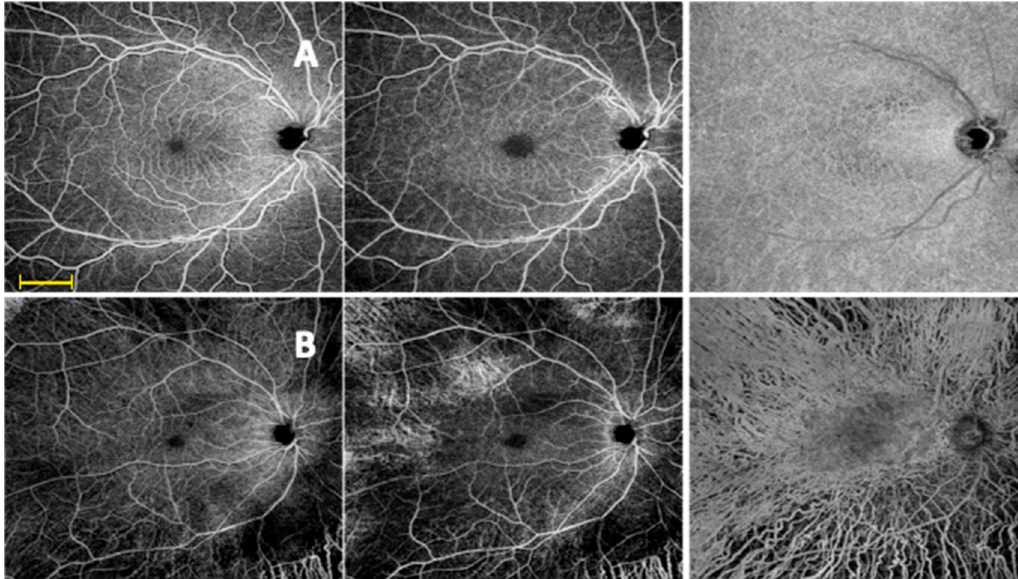
Figure 1. Widefield swept source optical coherence tomography (WSS-OCTA) assessment of superficial capillary plexus (left images), deep capillary plexus (middle images) and choriocapillaris (right images) in a 12 × 12 mm image of healthy eye ( A ) and retinitis pigmentosa (RP) patient ( B ). Scale bar = 3 mm.